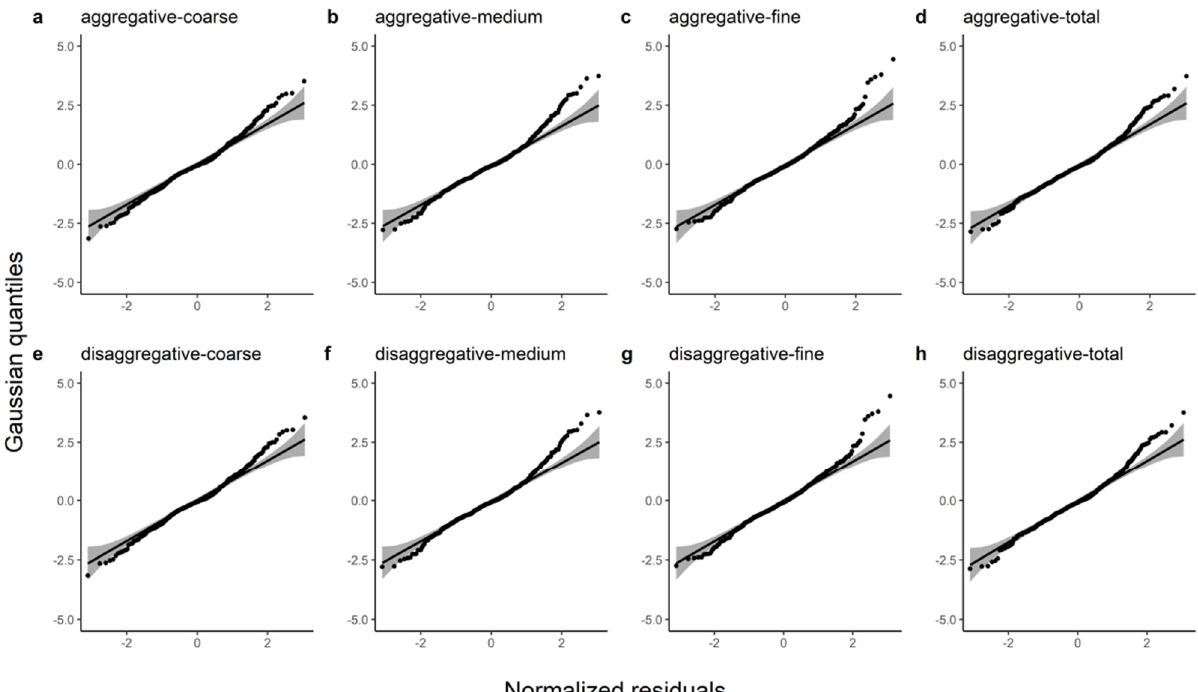
Figure 2. Gaussian probability plots of the normalized residuals from the additive and disaggregated models for the total root biomass and the component biomasses. ( a – d ) represent the predicted coarse, medium, fine and total roots from the additive model; ( e – h ) represent the coarse root, medium root, fine root and total root predicted by the disaggregated model.